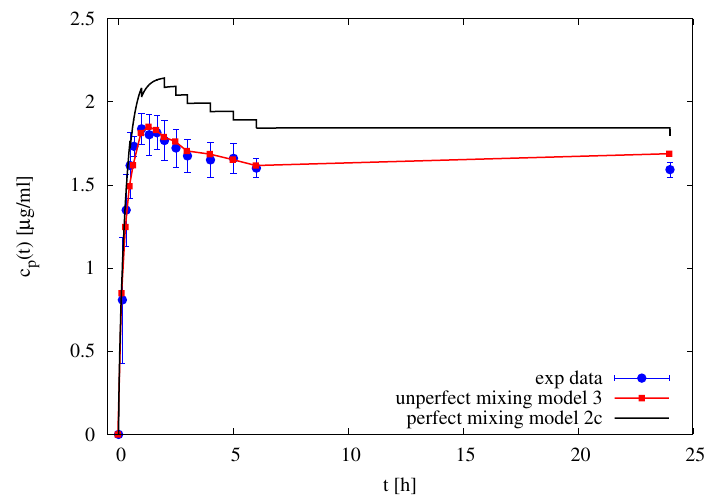
Figure 7. Differential release profile of furosemide blank solution. Filled circles represent experimental withdrawal concentrations c p ( t i ) . Continuous black line represents perfect mixing model predictions (Model IIc). The red line with square points represent the imperfect mixing model predictions (Model